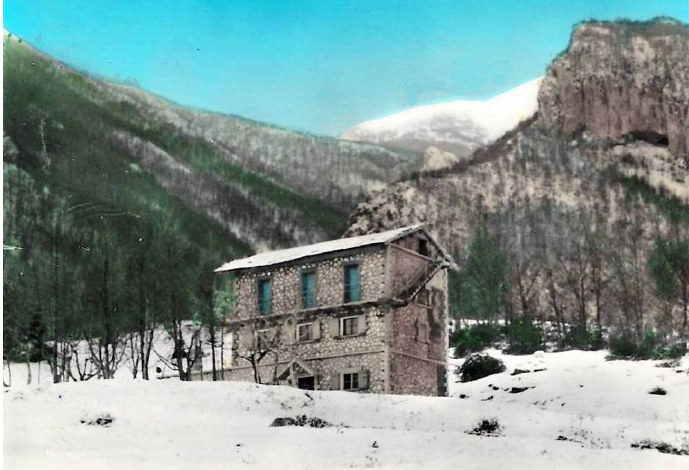
Figure 3. View of the original cabin Rifugio Rigopiano in the 1950s, with the Grava dei Bruciati and snow-covered Monte Siella in the background. Unknown photographer, image in public domain downloaded from [11] (originally uploaded from http://www.gelsumino.it/immagini/rigopiano.